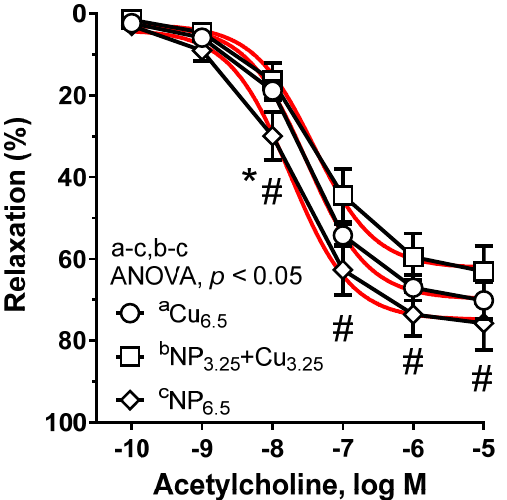
Figure 3. The relaxant response to acetylcholine in the isolated thoracic rings from rats supple-